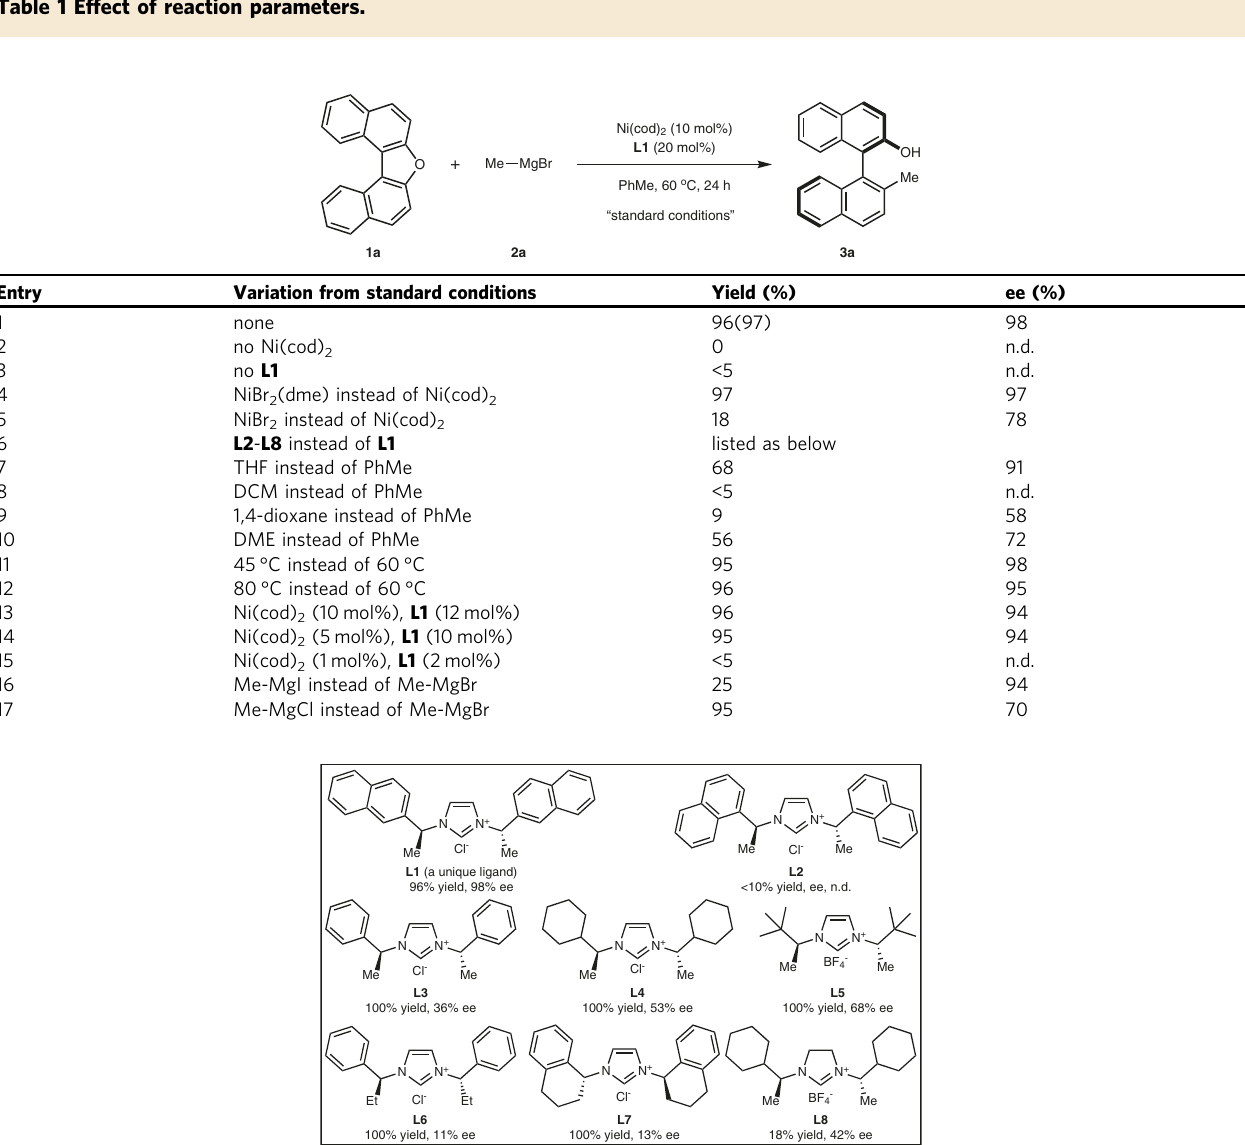
Table 1 Effect of reaction